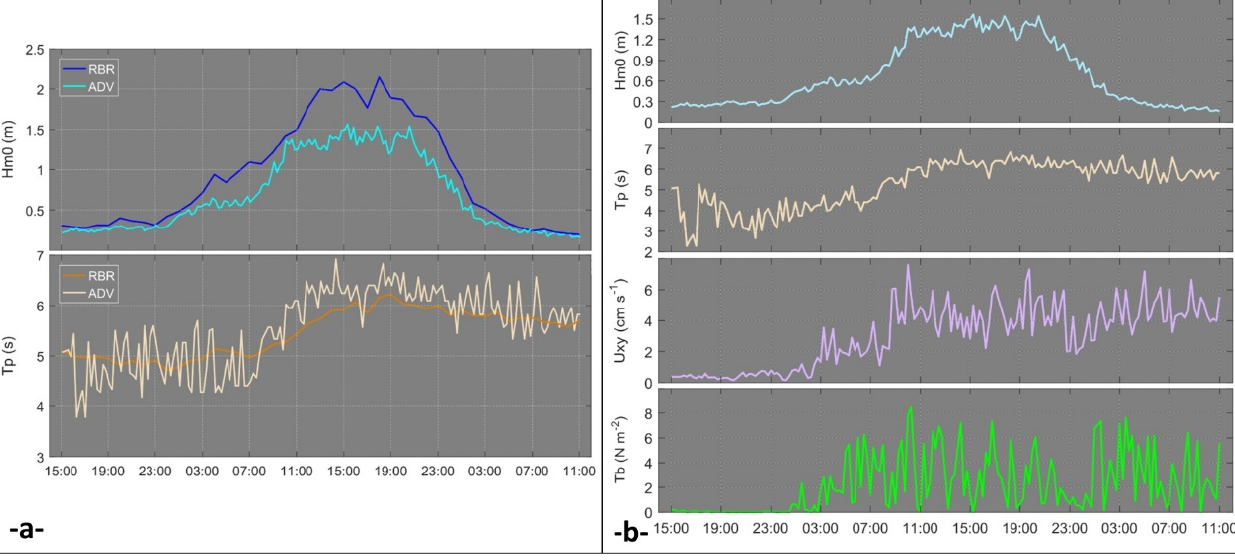
Figure 6. ( a ) Wave conditions (zero-moment wave height—H m0 and peak wave period—Tp) of a 44-h energetic event for which concurrent RBR (at 8 m depth) and ADV (at 1.7 m depth) hydrodynamic records are available (10–12 February 2021). ( b ) Wave characteristics, mean flow and bed shear stress recorded by the ADV sensor.